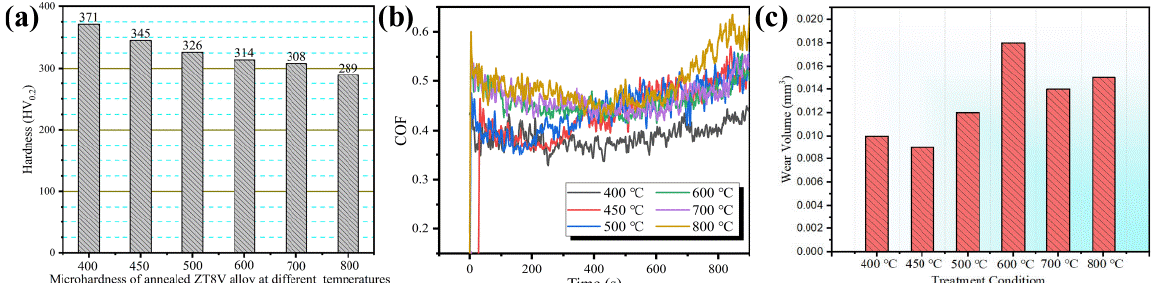
Figure 8. ( a ) Microhardness of the annealed Zr – Ti – 8V alloys. ( b ) Frictional wear curves of samples at different annealing temperatures. ( c ) Wear volume of the annealed Zr – Ti – 8V alloys.